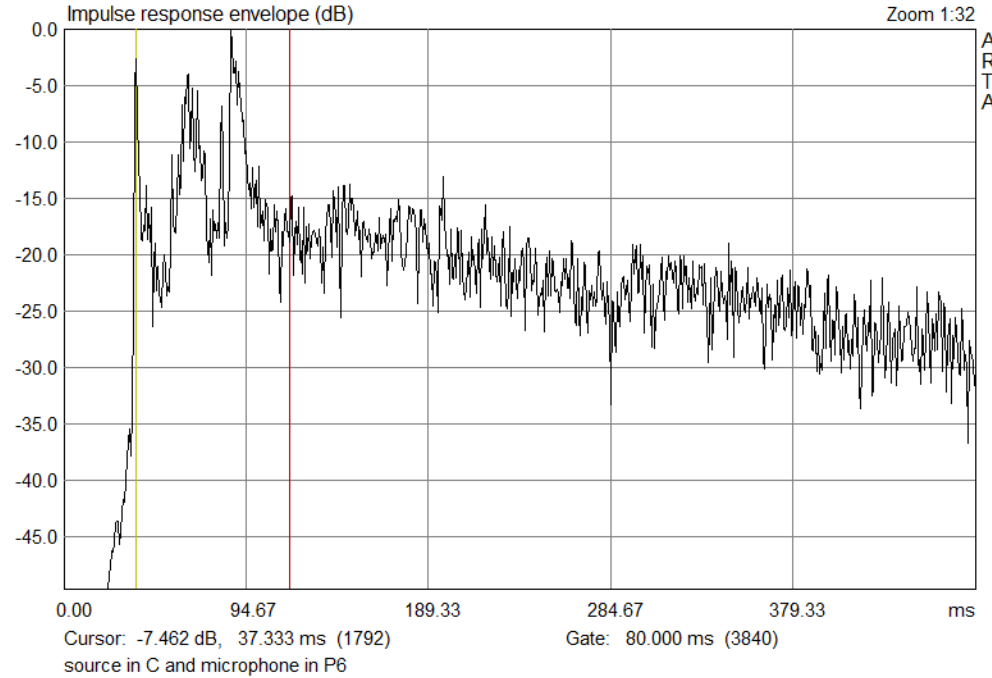
Figure 13. Energy–time curve (source in C, microphone in P6).